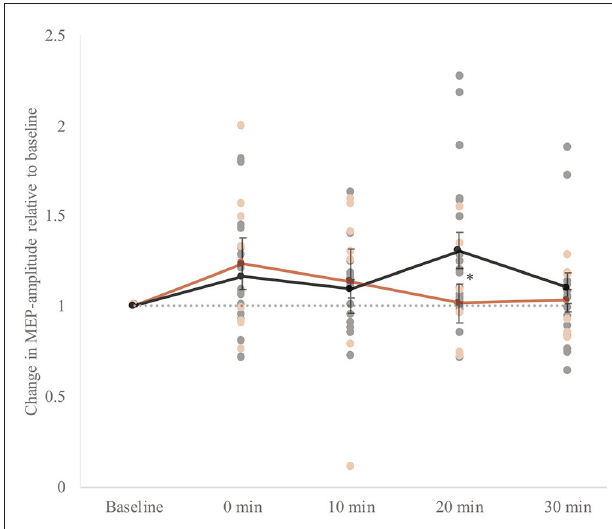
FIGURE 4 | Whole group analysis of cortical plasticity. The change in MEP amplitude (motor evoked potential) amplitudes ± SEM of the response upon induction of intermittent theta-burst stimulation (iTBS). Baseline: mean MEP in response to single pulses directly before iTBS. 0–30 min: mean MEP in response to single pulses four times within 30 mins after stimulation: 0, 10, 20, and 30 mins after stimulation. MEPs measured after stimulation were significantly higher in both groups ( F time (4, 88) = 3.4, p = 0.01, η 2 = 0.13). A gray dotted horizontal line at value 1.0 is plotted to interpret the potentiation. The individual data points are also presented. We did not find a significant group effect ( F group (1, 22) = 0.09, p = 0.8). However, there was an interaction effect between group and time ( F (4, 88) = 2.5, p = 0.05, η 2 = 0.10). In the control group, within-group analyses by means of t-tests showed that the MEP amplitude following iTBS was significantly higher 20 mins after stimulation ( i.e ., T3) ( t (17) = − 2.8, p = 0.01) indicated with an asterisk (*). In the patient group, within-group analyses showed that the MEP amplitude following iTBS was not significantly higher for any time point compared to